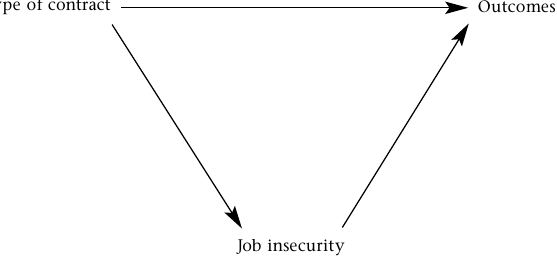
Figure 2: The mediational model Moderation